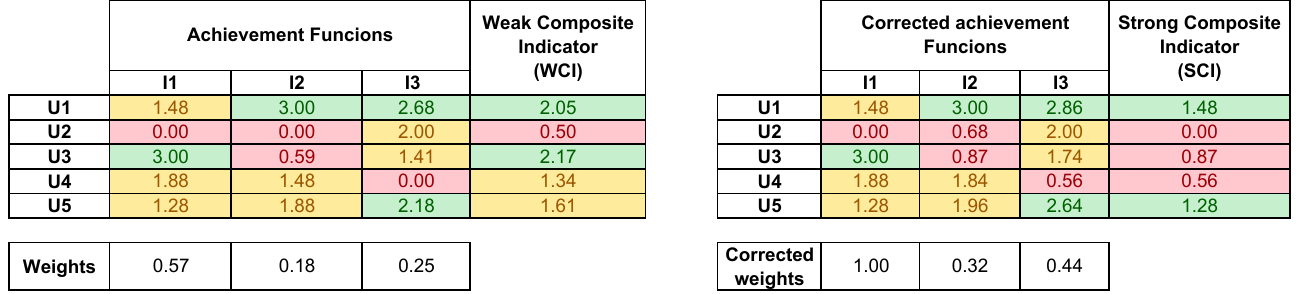
Figure A5. Normalization , weights and